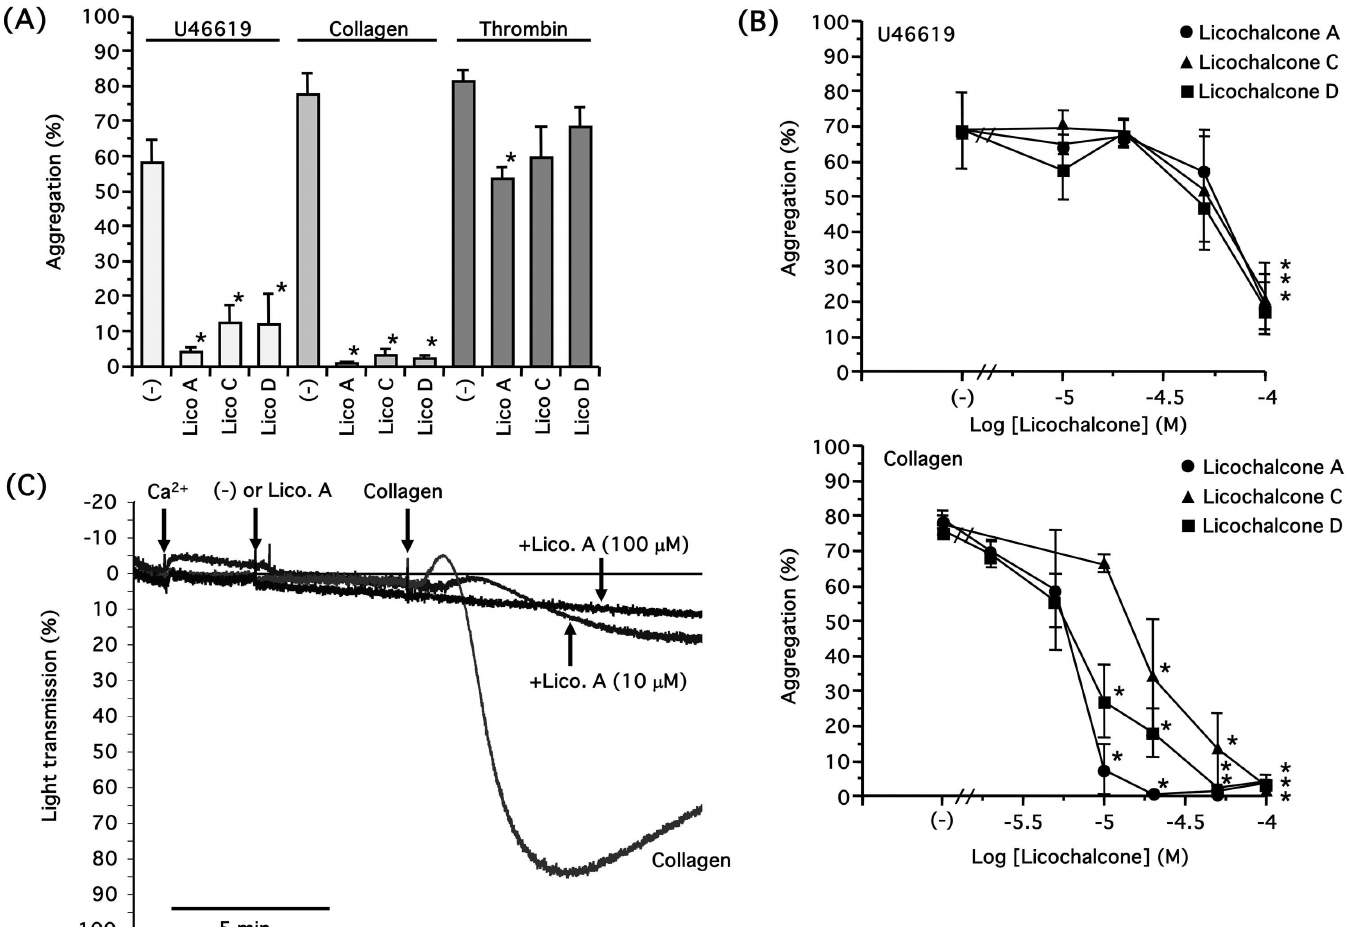
Fig 2. Concentration-dependent inhibition of U46619-and collagen-induced platelet aggregation by licochalcones. (A) Licochalcone A (Lico A, 100 μ M), licochalcone C (Lico C, 100 μ M), licochalcone D (Lico D, 100 μ M) or DMSO (-) was preincubated for 5 min before addition of U46619(3 μ M), collagen(3 μ g/ml) or thrombin(0.03 U/ml) in the presence of 1 mM CaCl 2 . Results are shownas mean ± S.E.M. ( * P < 0.05comparedwith control, n = 3, Tukey–Kramer’s method). (B) Licochalcones (2–100 μ M) or DMSO (control) were preincubated for 5 min before additionof U46619(3 μ M) or collagen(3 μ g/ ml) in the presenceof 1 mM CaCl 2 . Results are shown as mean ± S.E.M. ( * P < 0.05compared with control, n = 3–8, Dunnett’s method). (C) Licochalcone A (10 or 100 μ M) or DMSO (control) were preincubatedfor 5 min before additionof collagen(3 μ g/ml) in the presenceof 1 mM CaCl 2 . Representative traces of the collagen-induced platelet aggregationwith or without licochalcone A are